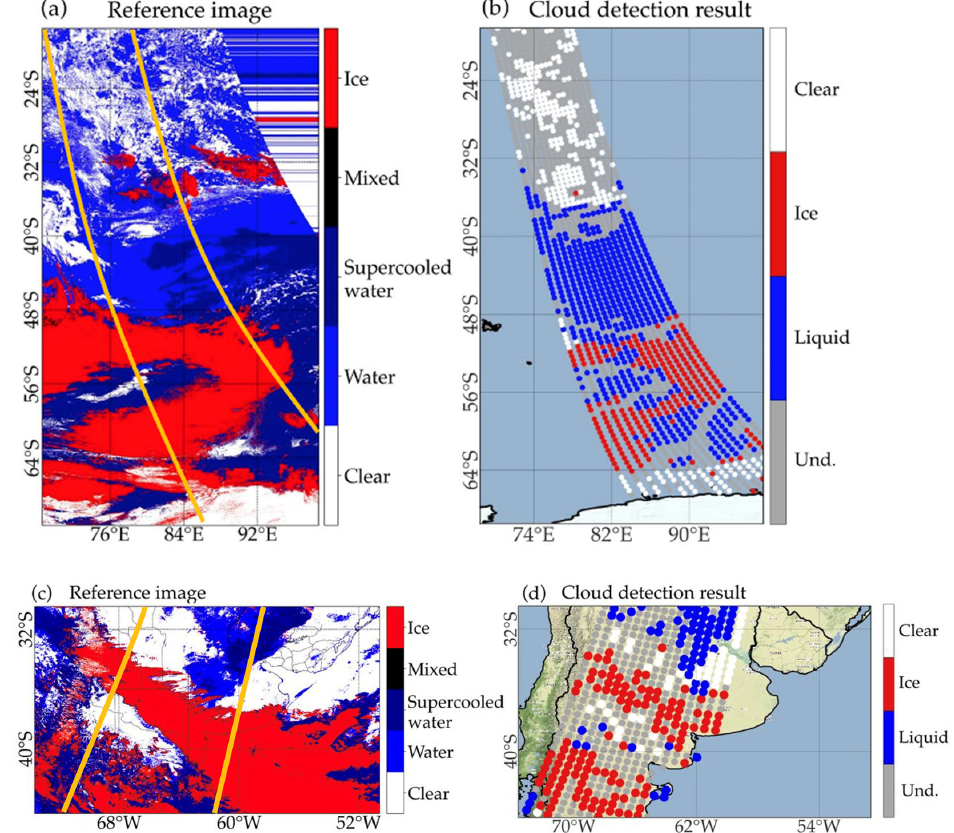
Figure 12. ( Top ): example for ocean background. ( a ) Pseudo-color image of the reference scene (date: 1 July 2022 19:40:19 orbit n. 18935.) ( b ) Cloud detection result of this scene. ( Bottom ): example for land background. ( c ) Pseudo-color image of the reference scene (date: 1 July 2022 04:31:24 orbit n. 18926). ( d ) Cloud detection result of this scene. (Und. stands for undetermined).